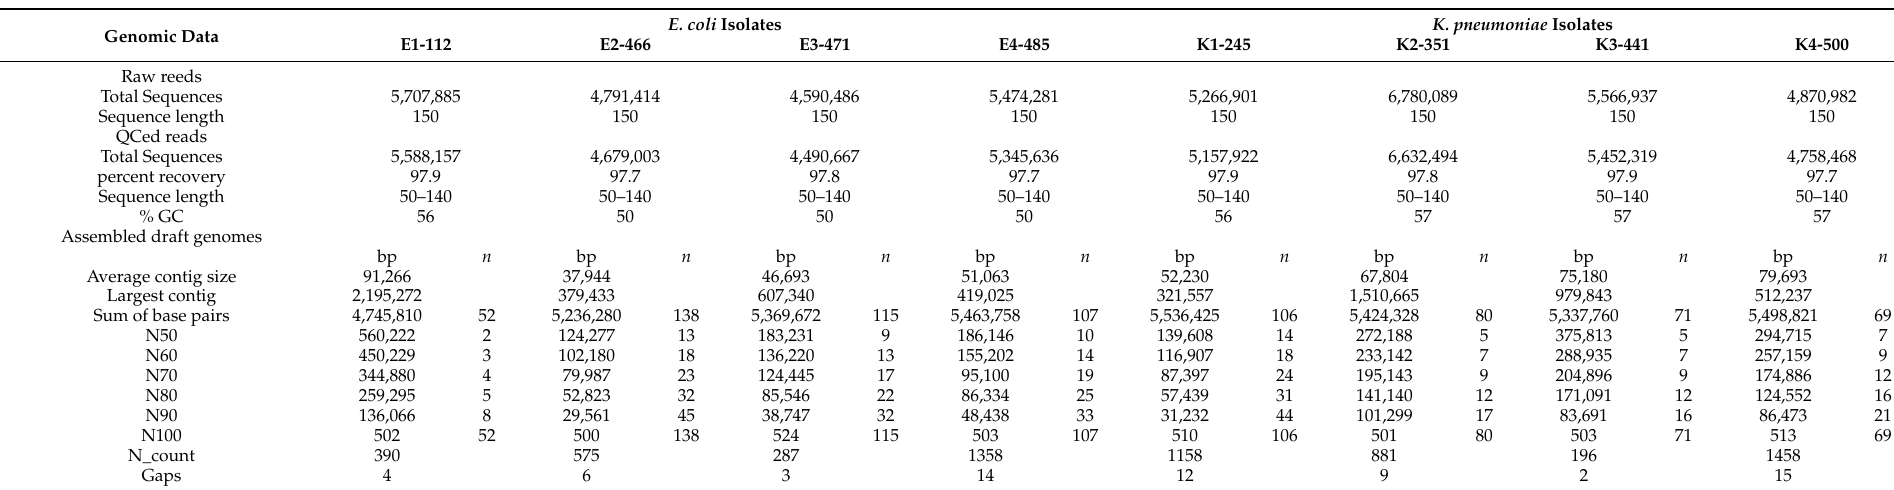
Table 3. The summary statistics of the assembled draft genomes of Escherichia coli and Klebsiella pneumoniae